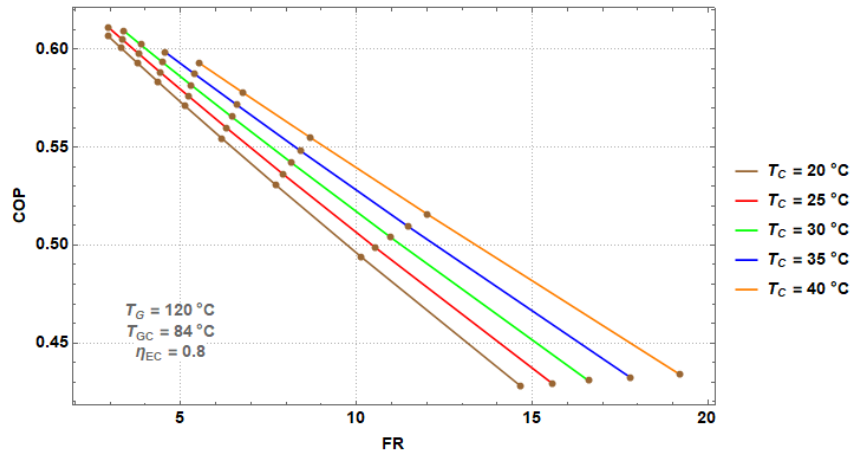
Figure 7. COP as a function of FR at different T C values for the DEHT.